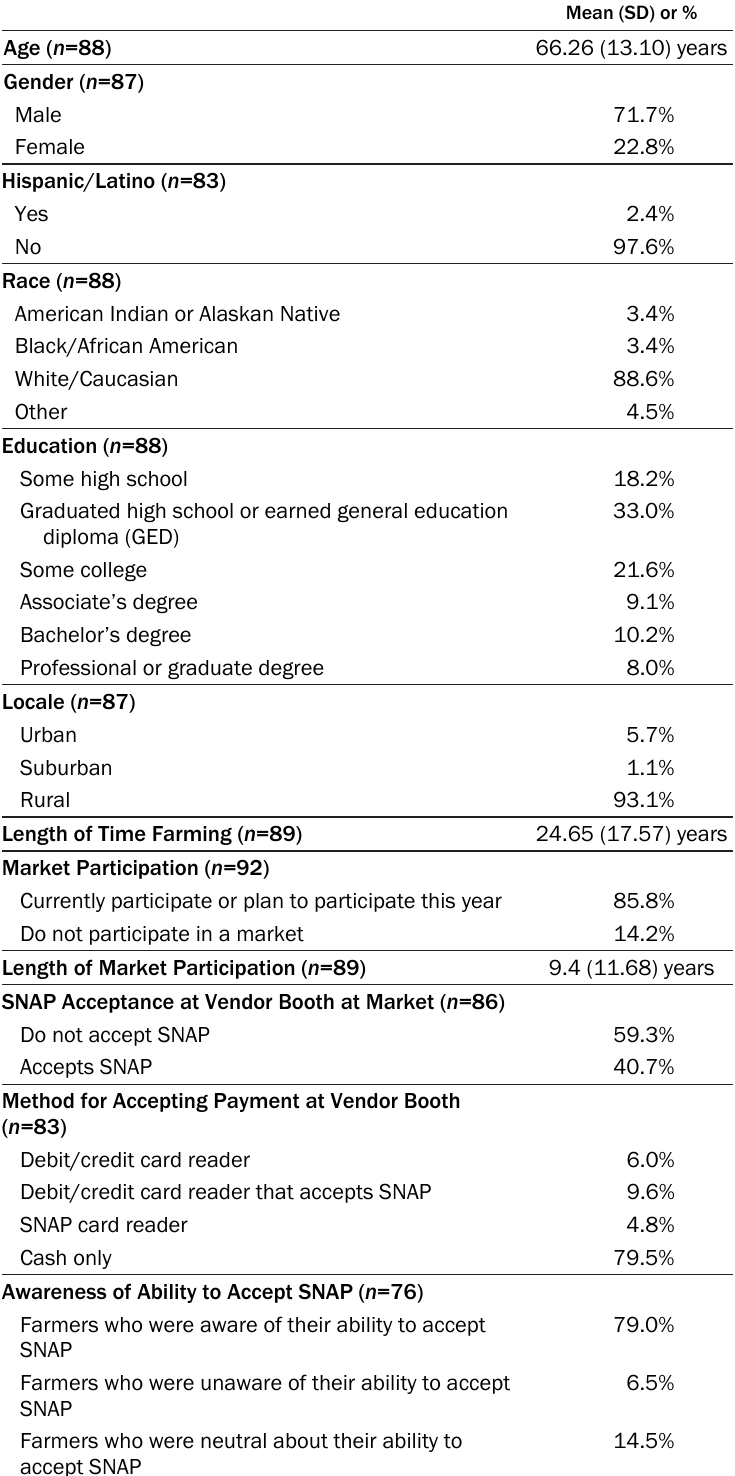
Table 1. Demographic Characteristics of Surveyed